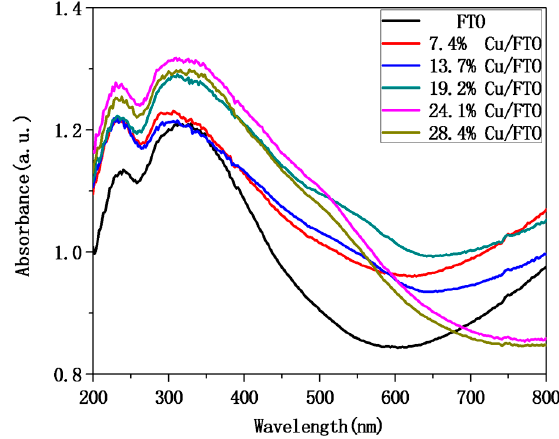
Figure 6. UV ‐ VIS DRS (UV ‐ visible diffuse ‐ reflectance spectrum) of FTO and Cu/FTO samples.